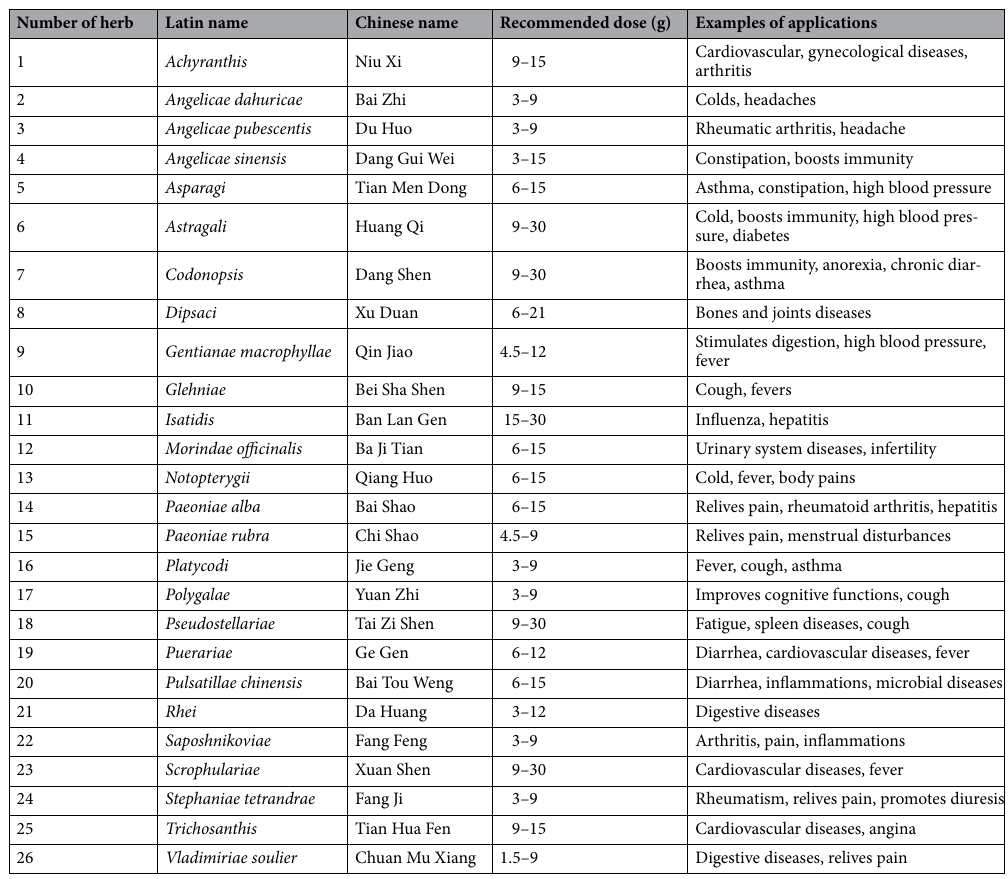
Table 1. Latin and Chinese names of investigated herbs and the recommended dose for preparation of a single infusion for medicinal